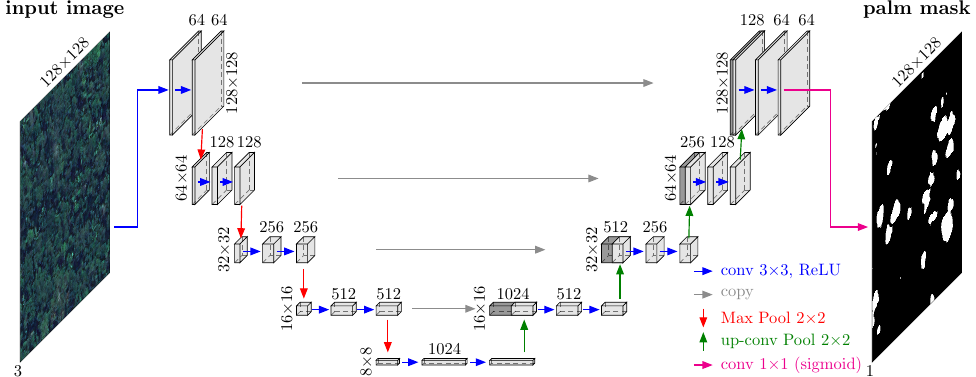
Figure 2. U-net architecture used for canopy palm segmentation, adapted from [19]. The number of channels and the row column size in pixels are indicated for each cuboid. ×